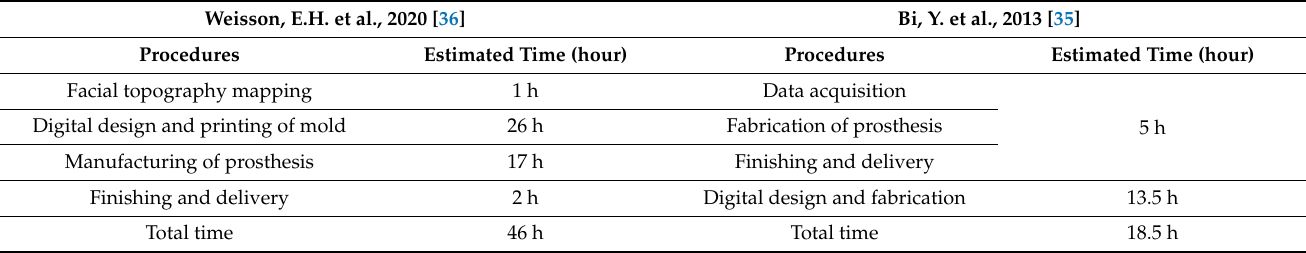
Figure 4. Digital workflow for the designing of surgical templates and manufacturing of orbital prostheses. Table 6. Estimated time for the designing and manufacturing of orbital prosthesis through digital